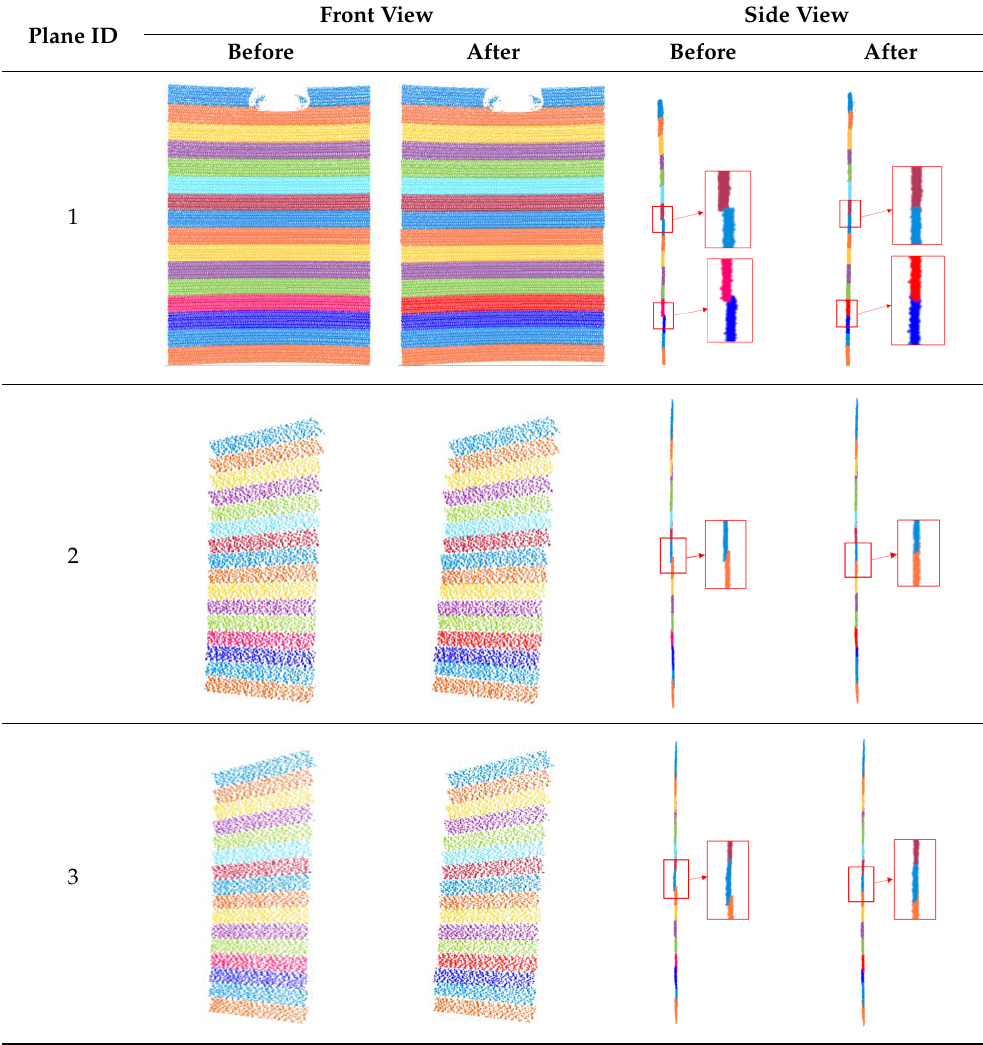
Table 3. Comparison of the point clouds before and after the calibration. Plane ID